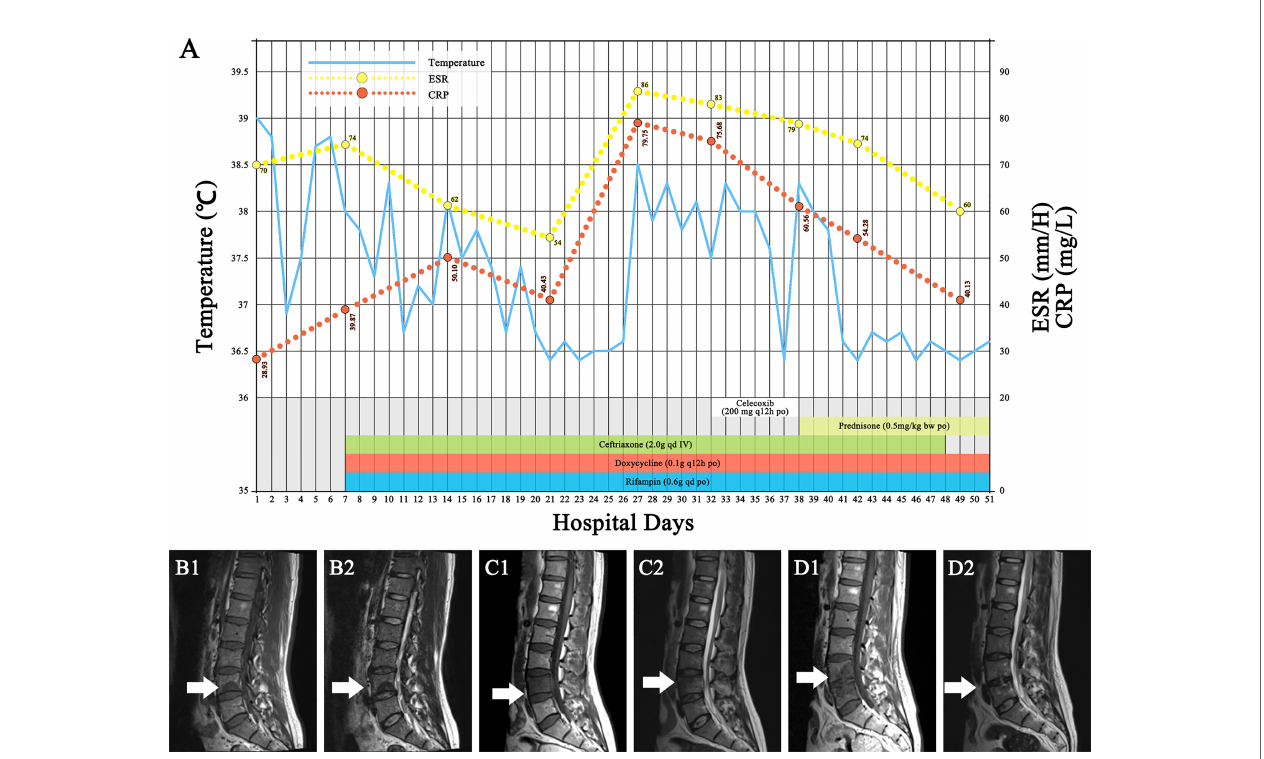
FIGURE 1 | Clinical data. (A) The hospitalization course, with the timeline of antibiotic treatment and the changes in body temperature and in fl ammatory markers. (B1, B2) The fi rst MRI scan of the patient showed a lesion on the lower 1 / 2 part of the fourth lumbar vertebra (white arrow), with low intensity on T1WI and high intensity on T2WI. (C1, C2) The second MRI scan, which occurred on follow-up day 27, showed that the lesion had expanded (white arrow), involving the posterior lower part of the fourth lumbar vertebra and with fusiform abscess formation behind the fourth vertebral body and lumbosacral soft tissue edema. (D1, D2) The last MRI scan (white arrow) after 3 months showed that the lower edge endplate of the fourth lumbar vertebra was damaged, the L4/L5 intervertebral disc was turbid, the retrovertebral abscess had disappeared, and the lumbosacral soft tissue edema was signi fi cantly improved. ESR, erythrocyte sedimentation rate; CRP, C-reactive